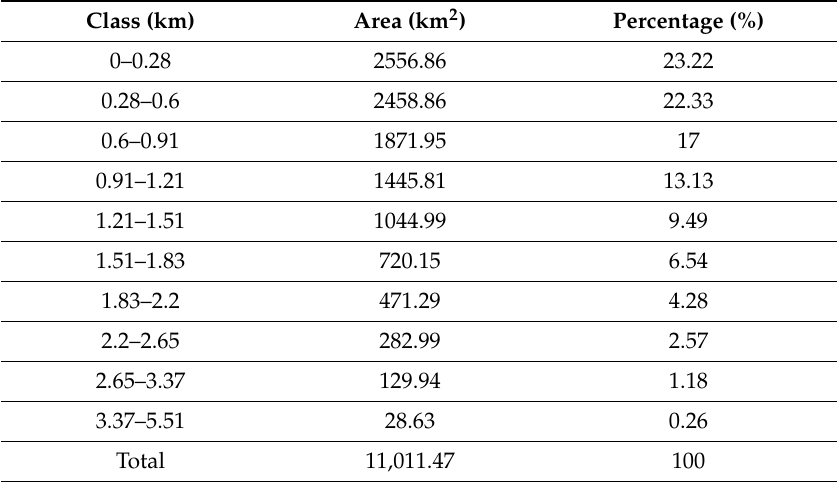
Table 11. Analysis of the distance from the wadi network in the study area in 2020.